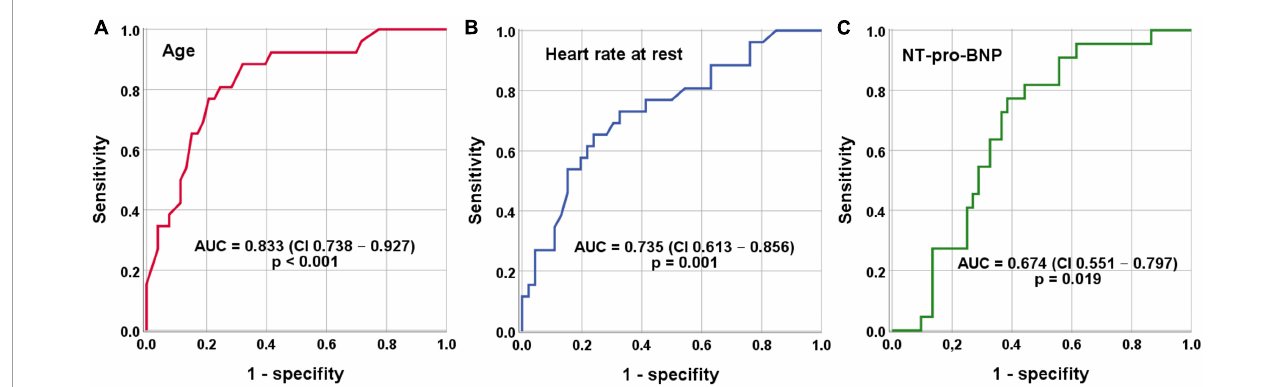
FIGURE2 Receiver operating characteristics (ROC) analysis for indication of AF/AFL induced TCM. (A) Cut-off value age < 79 years (sensitivity = 89% and specificity = 68%). (B) Cut-off value heart rate at rest > 112 beats per minute (sensitivity = 73% and specificity = 67%). (C) Cut-off value NT-proBNP < 5,419 pg/mL (sensitivity = 73% and specificity = 64%).